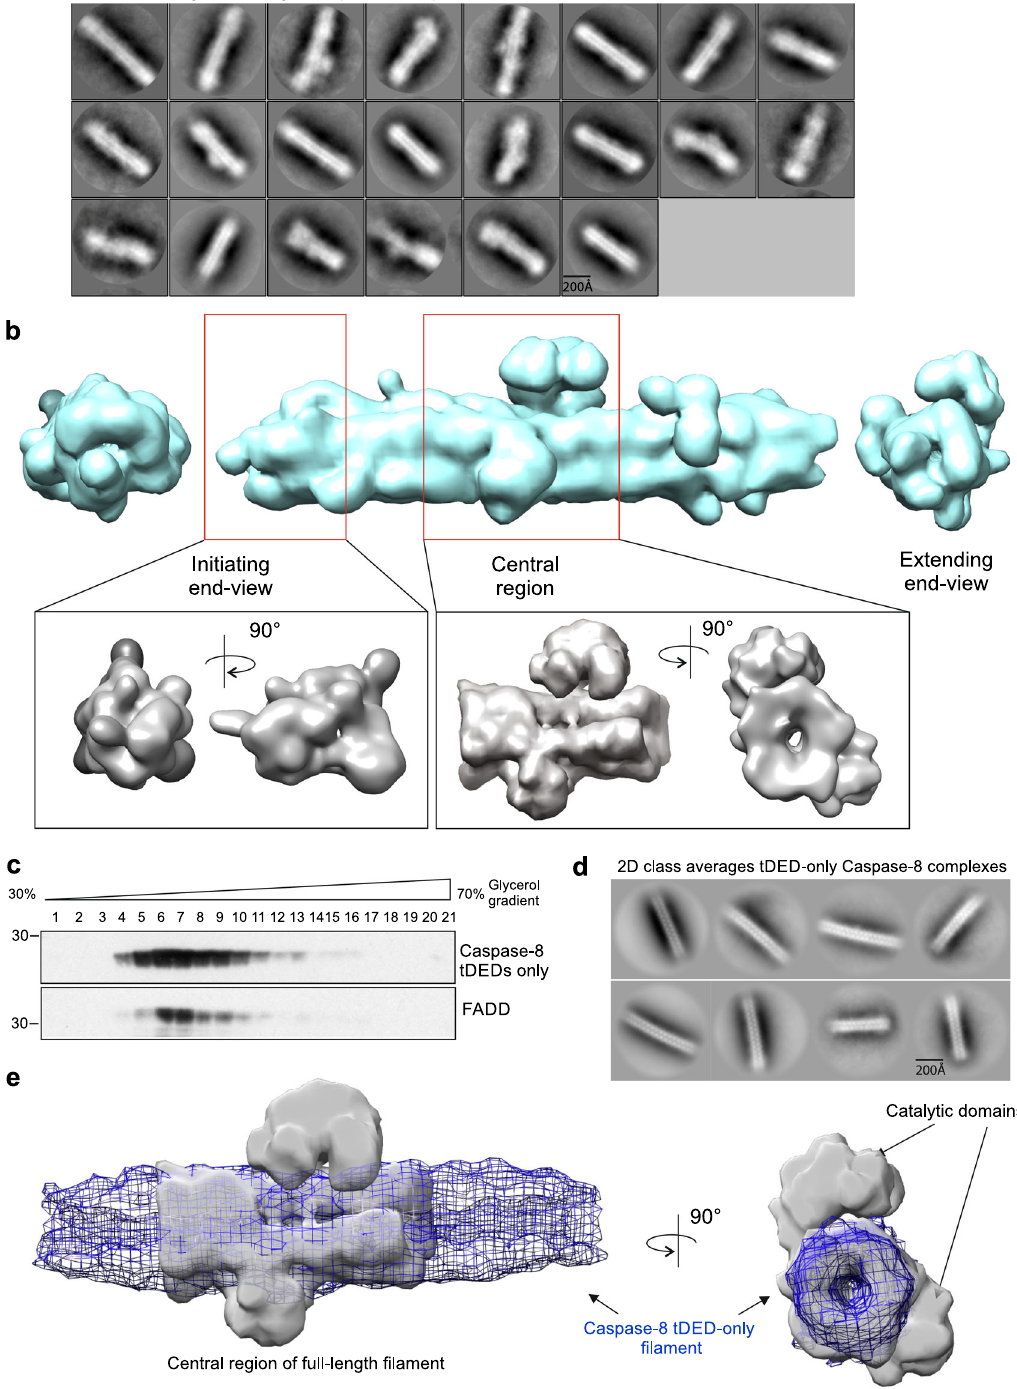
Fig. 2 Negative-stain EM model of FADD:full-length Caspase-8 fi lament. a Reference-free 2D class averages generated in RELION of negative-stain EM of FLAG-FADD:Caspase-8 complexes. b Initial model generated in CryoSPARC. Whole fi lament shown in blue (27 Å) with views of ‘ closed ’ initiating end (left) and ‘ open ’ extending end (right). Gray EM volumes are re fi nements of masked sections of the full fi lament; both the initiating end (17 Å) and central Caspase-8 only region of complex (14.5Å). c Western blot analysis of Glycerol Density Gradient puri fi cation of soluble FADD:Caspase-8 tDED- only (expressed together with FLAG-c-FLIP S to stabilize the tDED-only complexes). Western blots are representative of 3 independent experiments. d Reference-free 2D class averages generated in CryoSPARC of negative-stain EM of FADD:Caspase-8 tDED-only complexes. e Overlay of initial model generated in CryoSPARC of central region of Caspase-8 tDED-only complex (mesh) with EM volume of central region of full-length Caspase-8 fi lament. Source data are provided as a Source Data fi